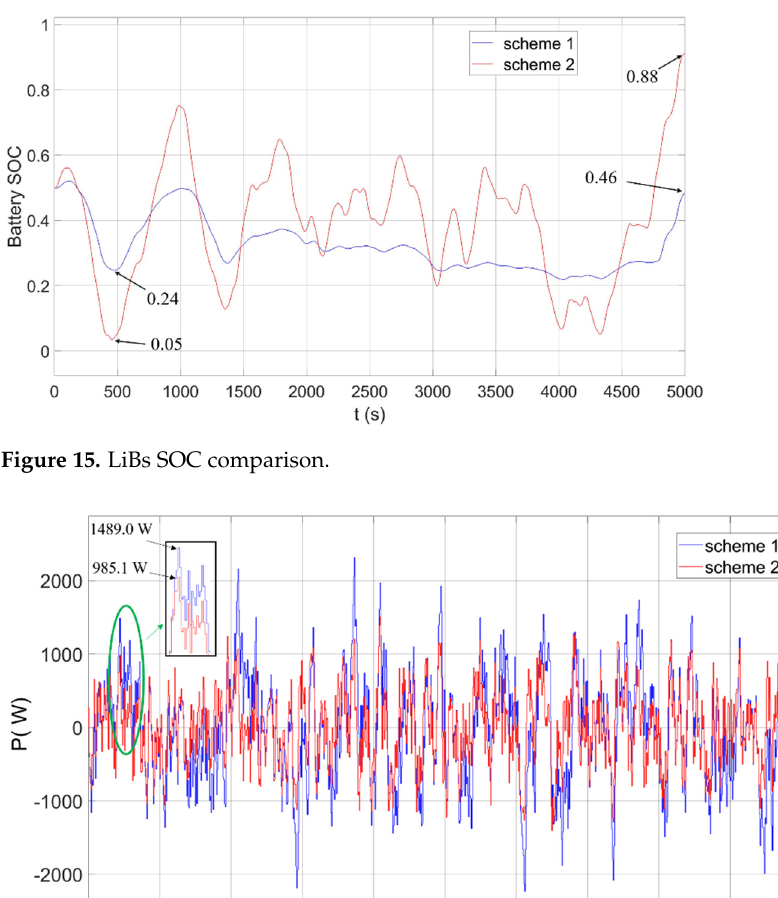
Figure 14. LiBs assumed power comparison.